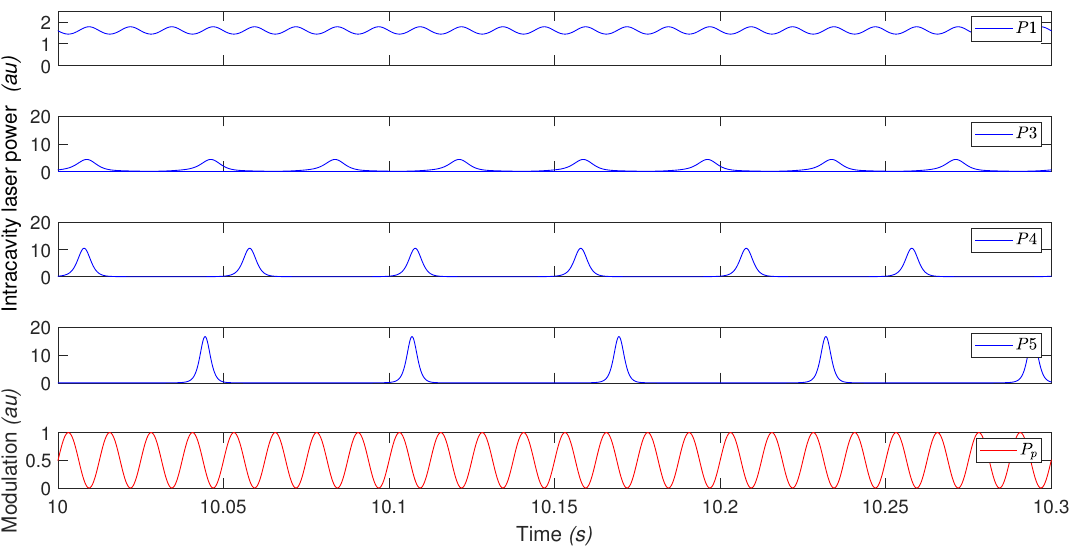
Figure 3. Time series of the laser intensity corresponding to coexisting P 1, P 3, P 4, and P 5 regimes at f 0 = 80kHz and m 0 =